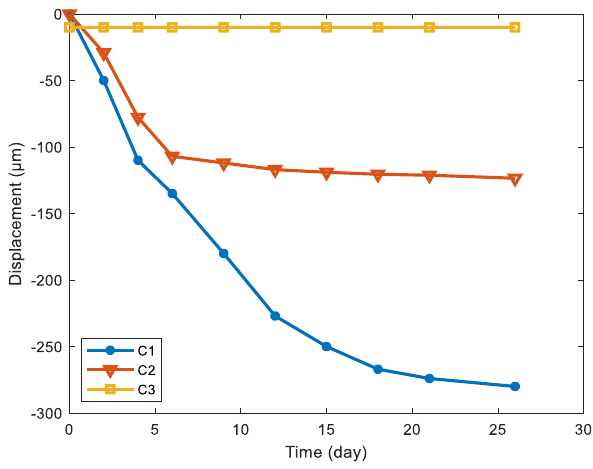
Figure 14: Measured radial displacements ( μ m ) .